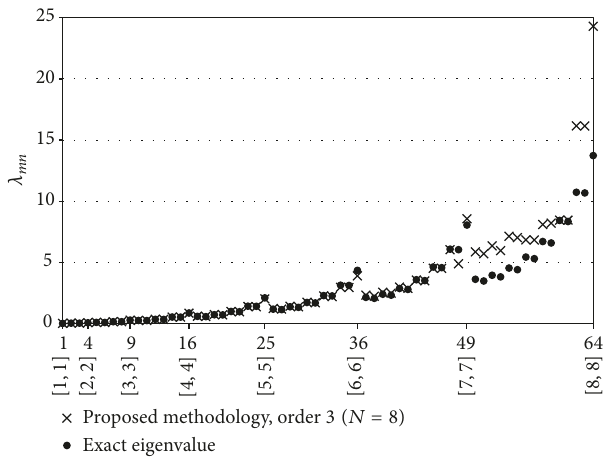
Figure 29: Eigenvalues (hinged rectangular plate; third-order brick, 𝑁 = 8 ).